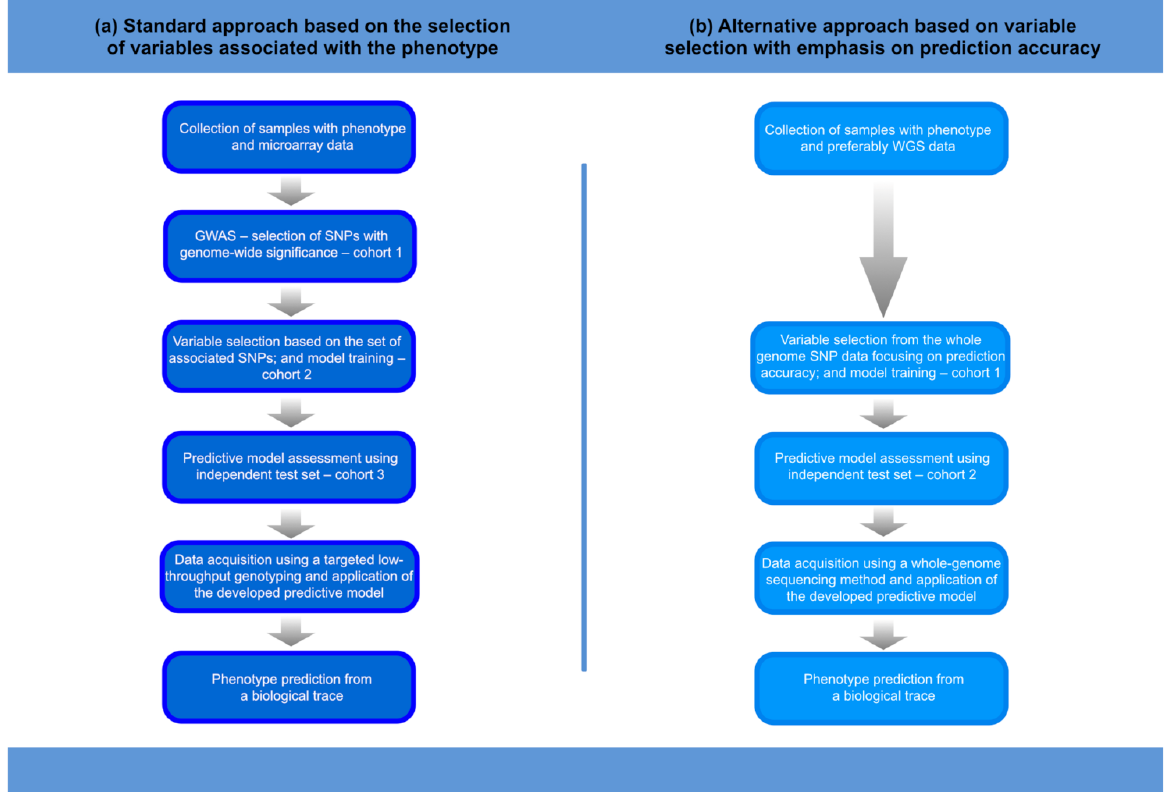
Figure 1. Procedure for the development and application of a phenotype prediction tool. The main differences in the procedures for developing a predictive model using the standard or alternative approach concern the selection of variables and the number of variables in the model. Consequently, the method of acquiring genetic data in the practical forensic applications of the next-generation predictive models may require whole-genome sequencing methods. Thus: ( a ) only phenotype- associated SNPs are included in prediction modelling, the models are not very extensive, and the methods of data acquisition can be less complex (SNaPshot, targeted MPS); ( b ) the selection of relevant variables (SNPs) is targeted towards improving the prediction accuracy of the model, and much more advanced variable selection methods are required. Some complex models may involve many thousands of SNPs, which, in biological traces, must be analysed using whole-genome sequencing methods that are effective for low DNA input